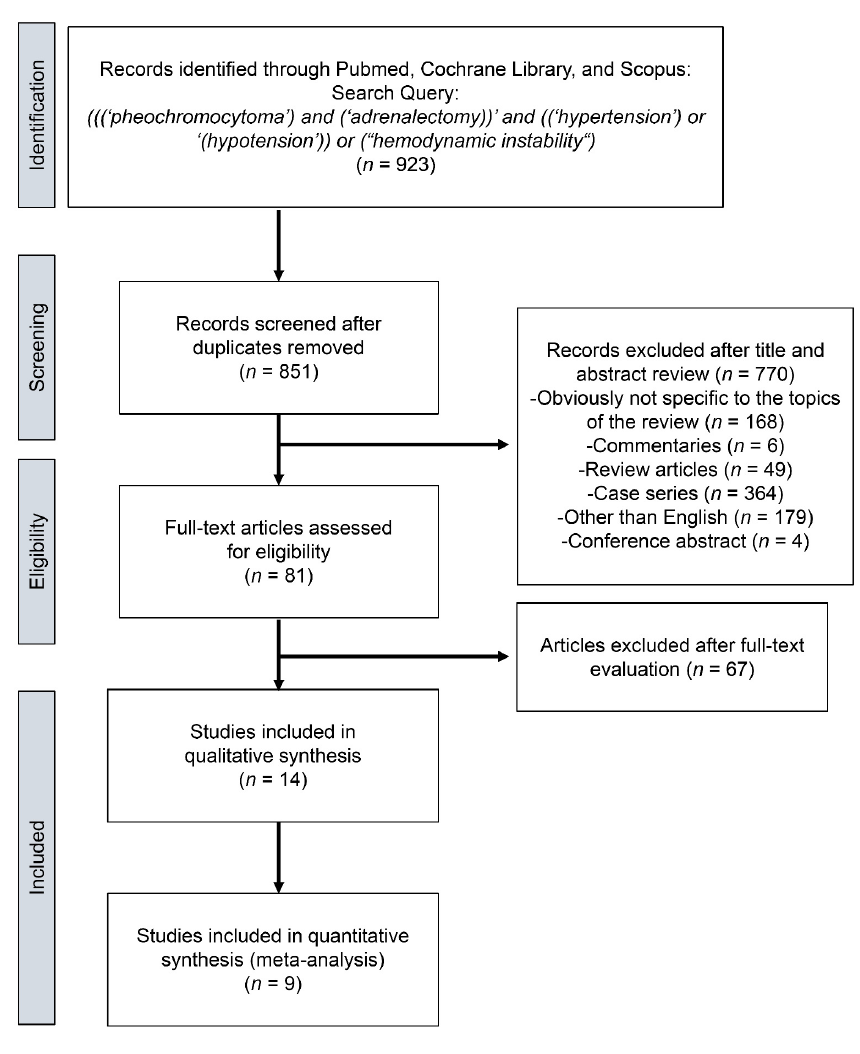
Figure 1. Preferred Reporting Items from the Systematic Review and Meta-Analysis (PRISMA) flow chart showing the process of article selection to analyze risk factors for hemodynamic instability in pheochromocytoma.